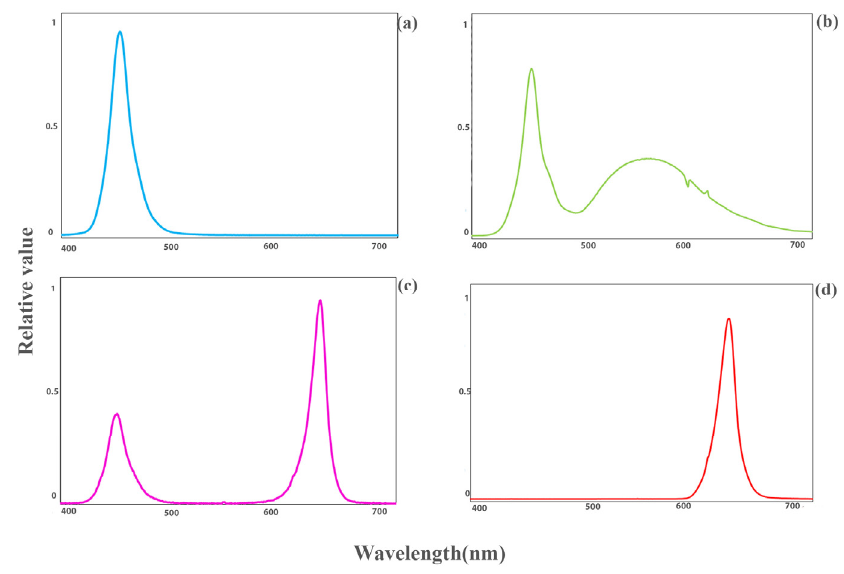
Figure 1. Light spectra of blue (( a ); 400–500 nm), white (( b ); 35% blue (400–500 nm), 48% intermediate (500–600 nm), and 16% red (600–700 nm)) as control, red and blue (( c ); 32% blue (400–500 nm), and 68% red (600–700 nm)), and red (( d ); 600–700 nm) light quality regimes under study.